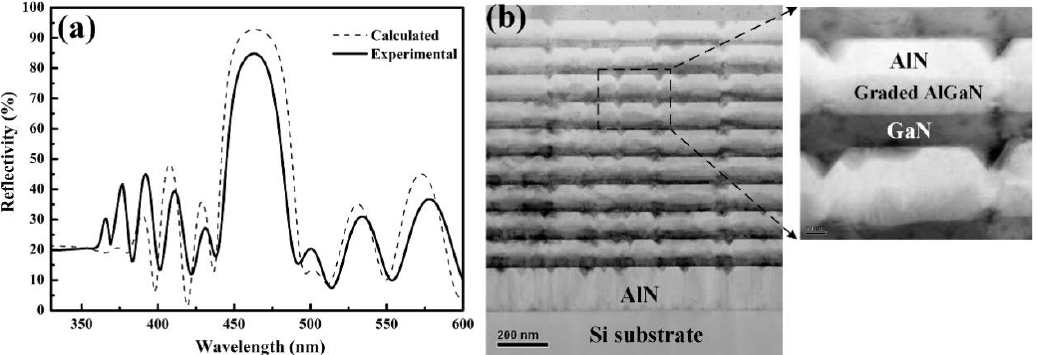
Figure 4. ( a ) The experimental and calculated reflectivity and ( b ) cross-sectional TEM images of the optimized 9-pair AlN / GaN DBRs. optimized 9-pair AlN/GaN DBRs.